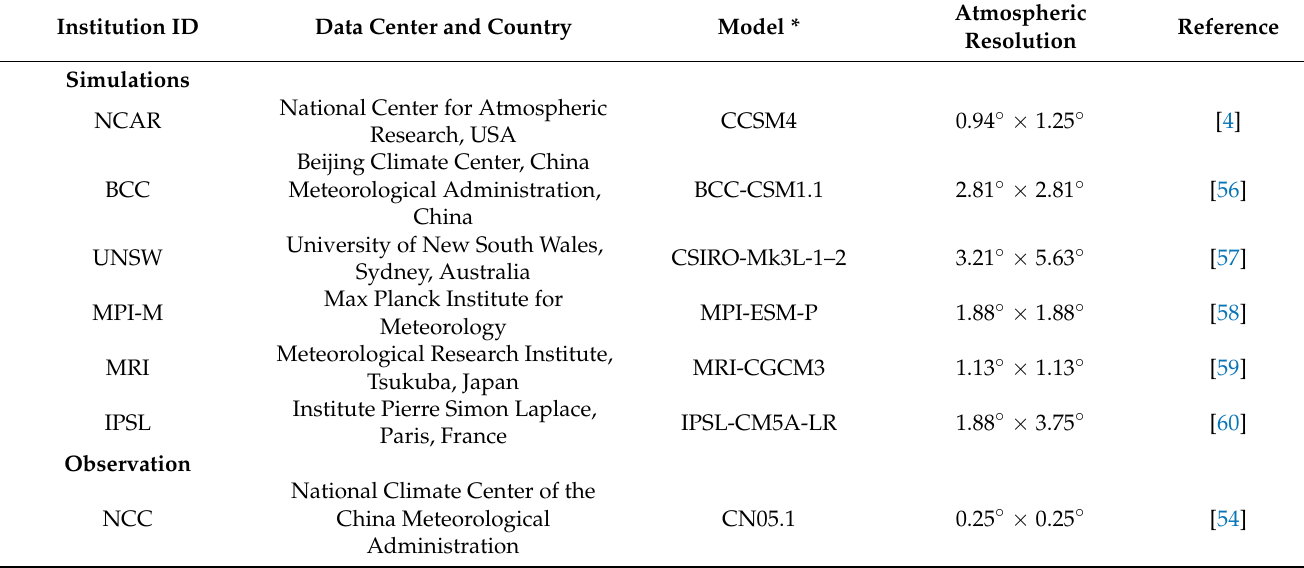
* represents the abbreviations of models and observation. Full names are Community Climate System Model version 4.0 (CCSM4), Beijing Climate Center Climate System Model version 1.1 (BCC-CSM1.1), Commonwealth Scientific and Industrial Research Organization Mark 3 Low-resolution model version 1.2 (CSIRO-Mk3L-1-2), Earth System Model of Max-Plank-Institut für Meteorologie: low resolution grid and paleo mode (MPI-ESM-P), Meteorological Research Institute Coupled Ocean-Atmosphere General Circulation Model version 3 (MRI-CGCM3), Earth System Model of the Institut Pierre Simon Laplace: Low Resolution (IPSL-CM5A-LR), 0.5 ◦ × 0.5 ◦ daily temperature dataset over China